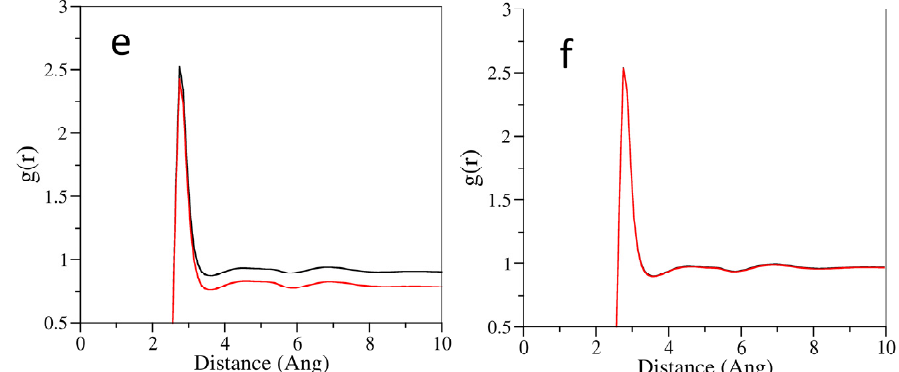
Figure 7. The radial distribution functions for water oxygen–water oxygen (O w –O w ) sites of formulations without cosolvents (dark line) and the formulations containing cosolvents (red line). ( a ) represents the Cyclosporine system, ( b ) represents the Docetaxel system, ( c ) represents the Etoposide system, ( d ) represents the Paclitaxel system, ( e ) represents the Valrubicin system, and ( f ) represents the Cabazitaxel system.